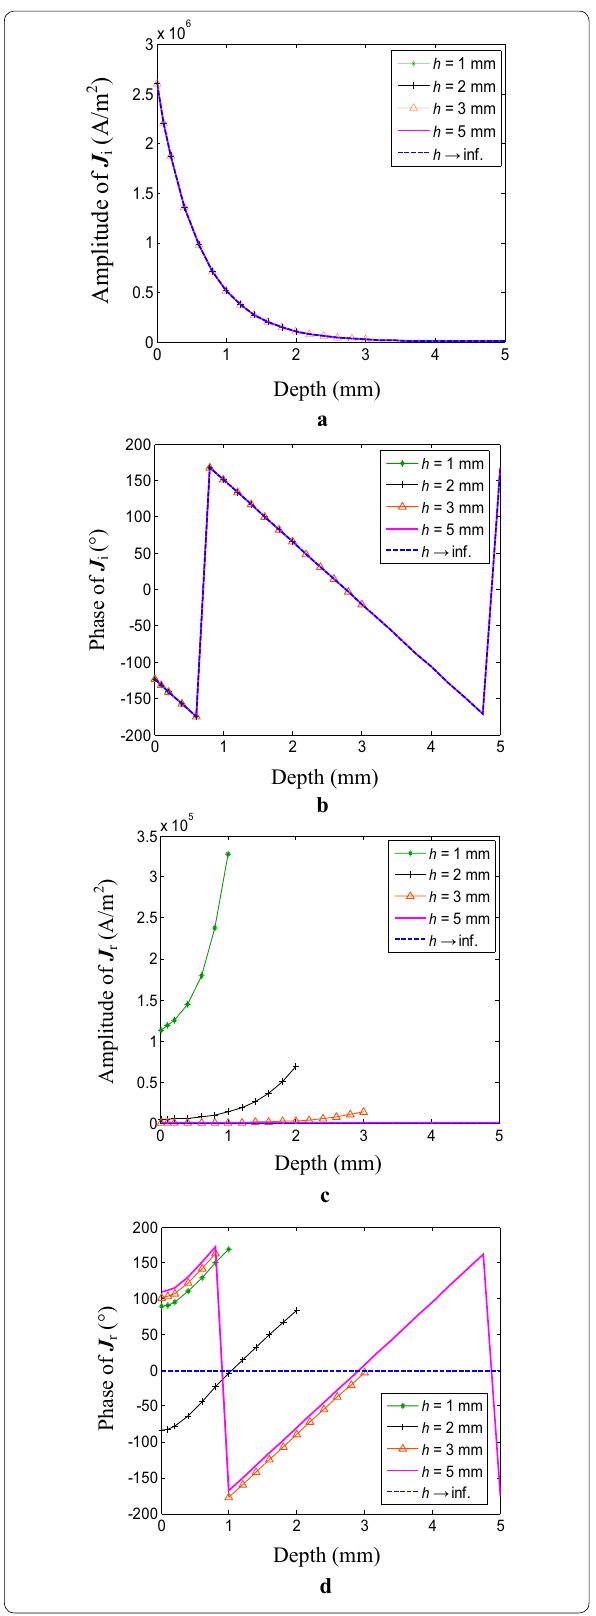
Figure 5 Incidence EC densities and reflection EC densities as functions of depth for various plate thicknesses at 30 kHz: a amplitudes of incidence EC densities; b phases of incidence EC densities; c amplitudes of reflection EC densities; d phases of reflection EC